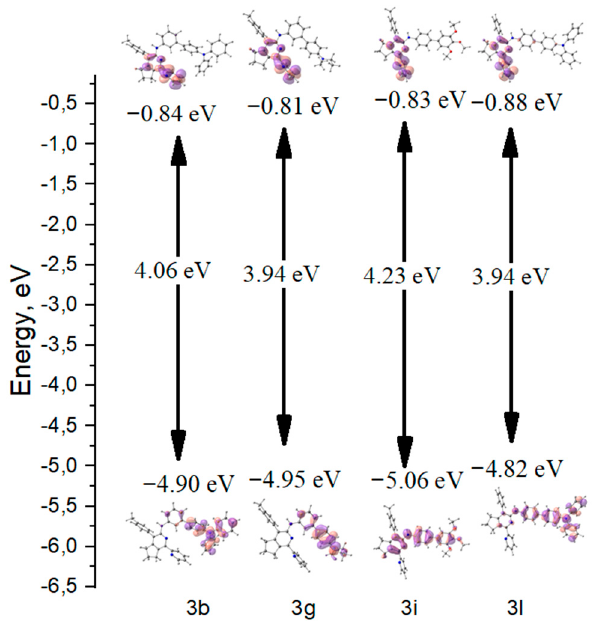
Figure 7. Frontier molecular orbitals and the energy level diagrams of 3b , g , i , l .